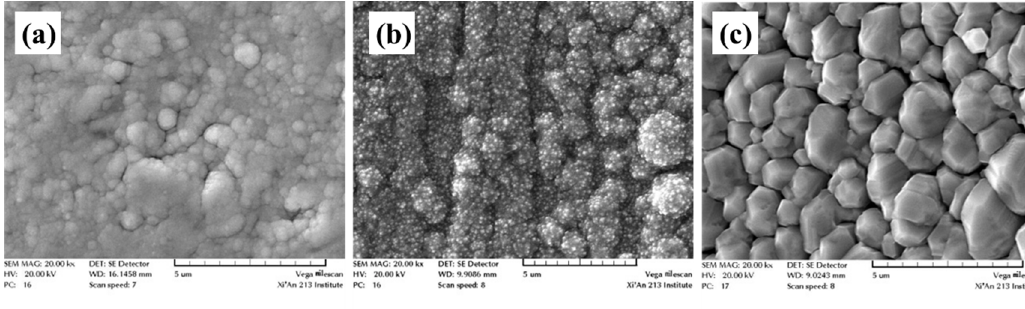
Figure 4. SEM images of Cu foil. ( a ) Sample A, ( b ) Sample B, and ( c ) Sample C.